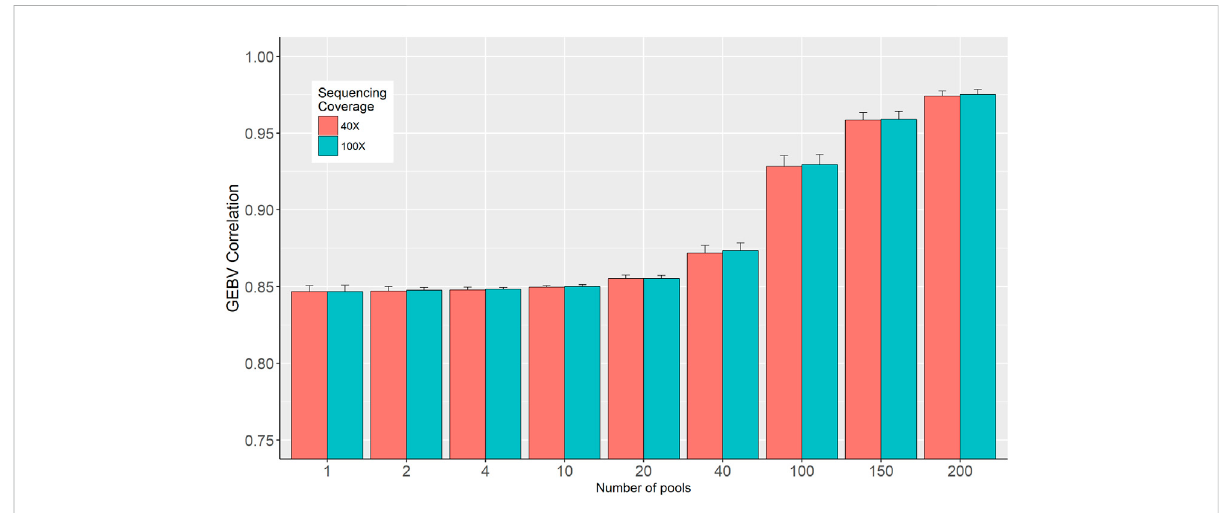
FIGURE 5 Correlation between genomic breeding values (GEBV) estimated from individual genotypes and in-silico DNA pool genotypes.